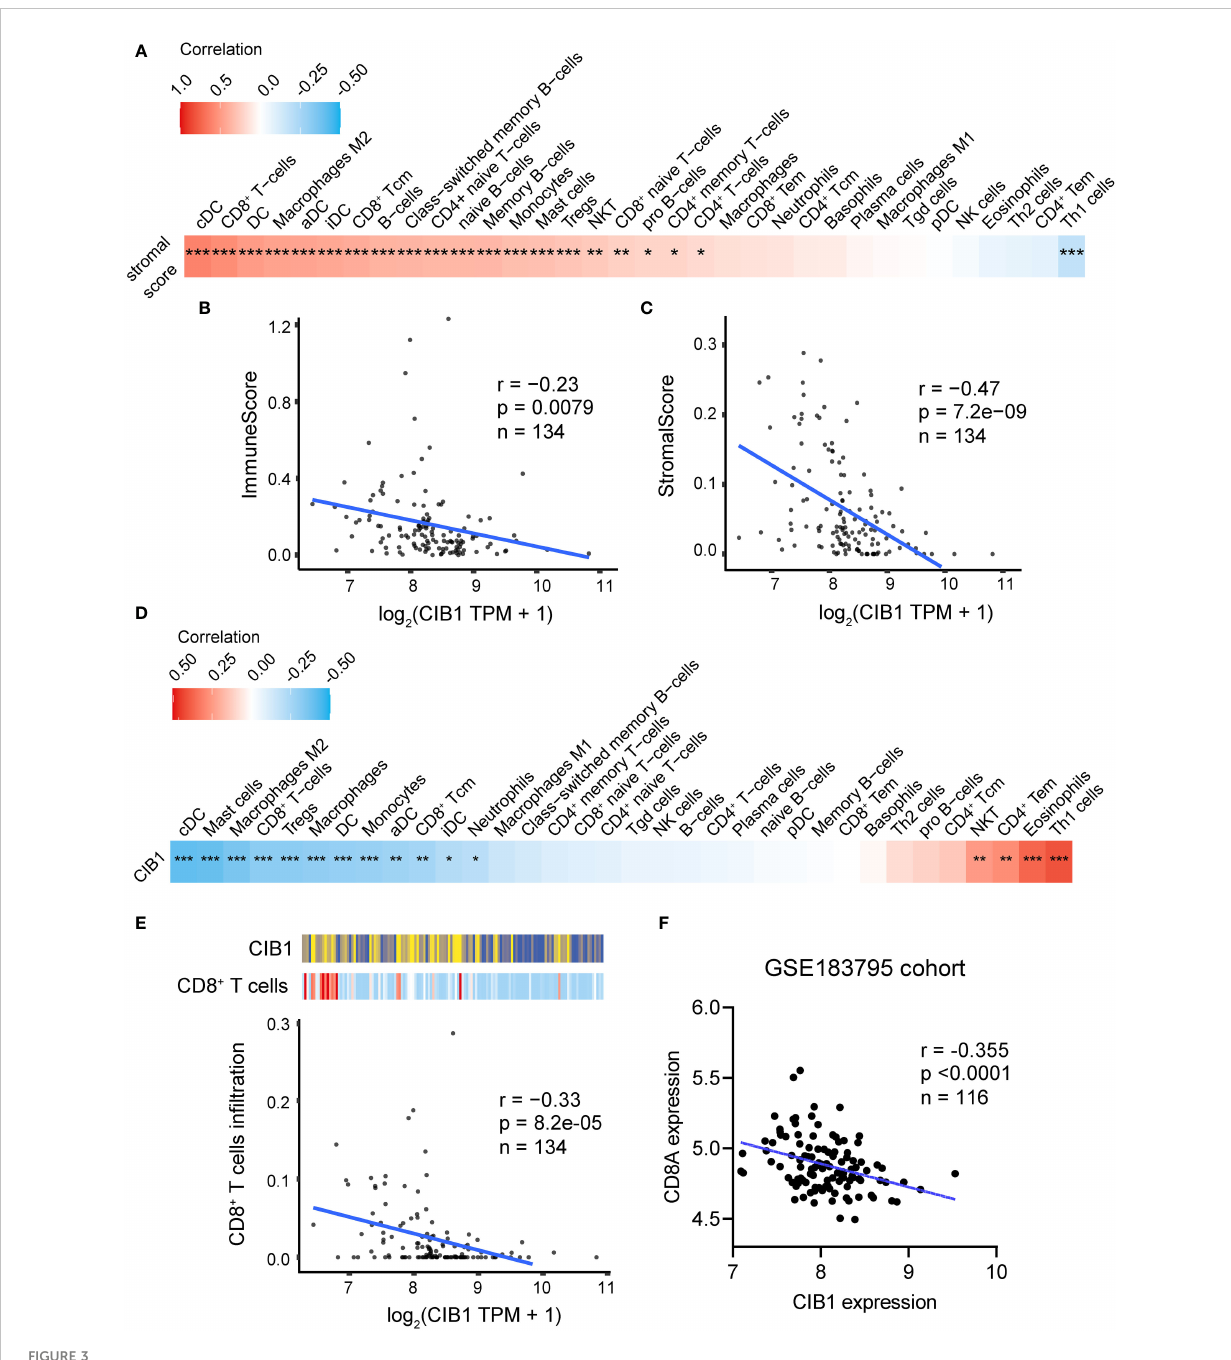
FIGURE 3 High expression of CIB1 was associated with low immune cell in fi ltration. (A) Correlation coef fi cients between stromal score and immune cell in fi ltration. Red represents a positive correlation, blue represents a negative correlation, and white represents no correlation. (B) Correlation scatterplots of CIB1 and immune score. (C) Correlation scatterplots of CIB1 and stromal score. (D) Correlation coef fi cients between CIB1expression and immune cell in fi ltration. (E) Correlation scatterplots of CIB1 and CD8 + T cells. (F) Correlation scatterplots of CIB1 expression and CD8A expression in GSE183795 cohrot, *p< 0.05, **p< 0.01, ***p<